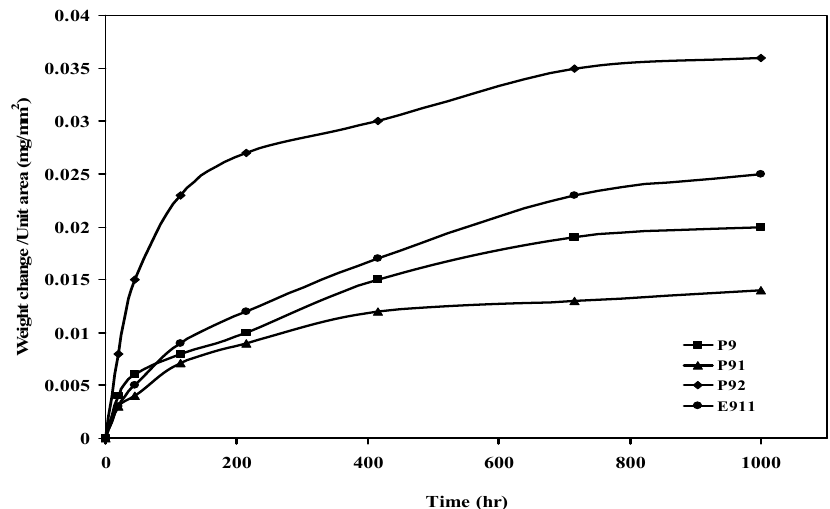
Figure 1. Weight change vs. time plots for the oxidation of alloys at 873 K in air for 1000